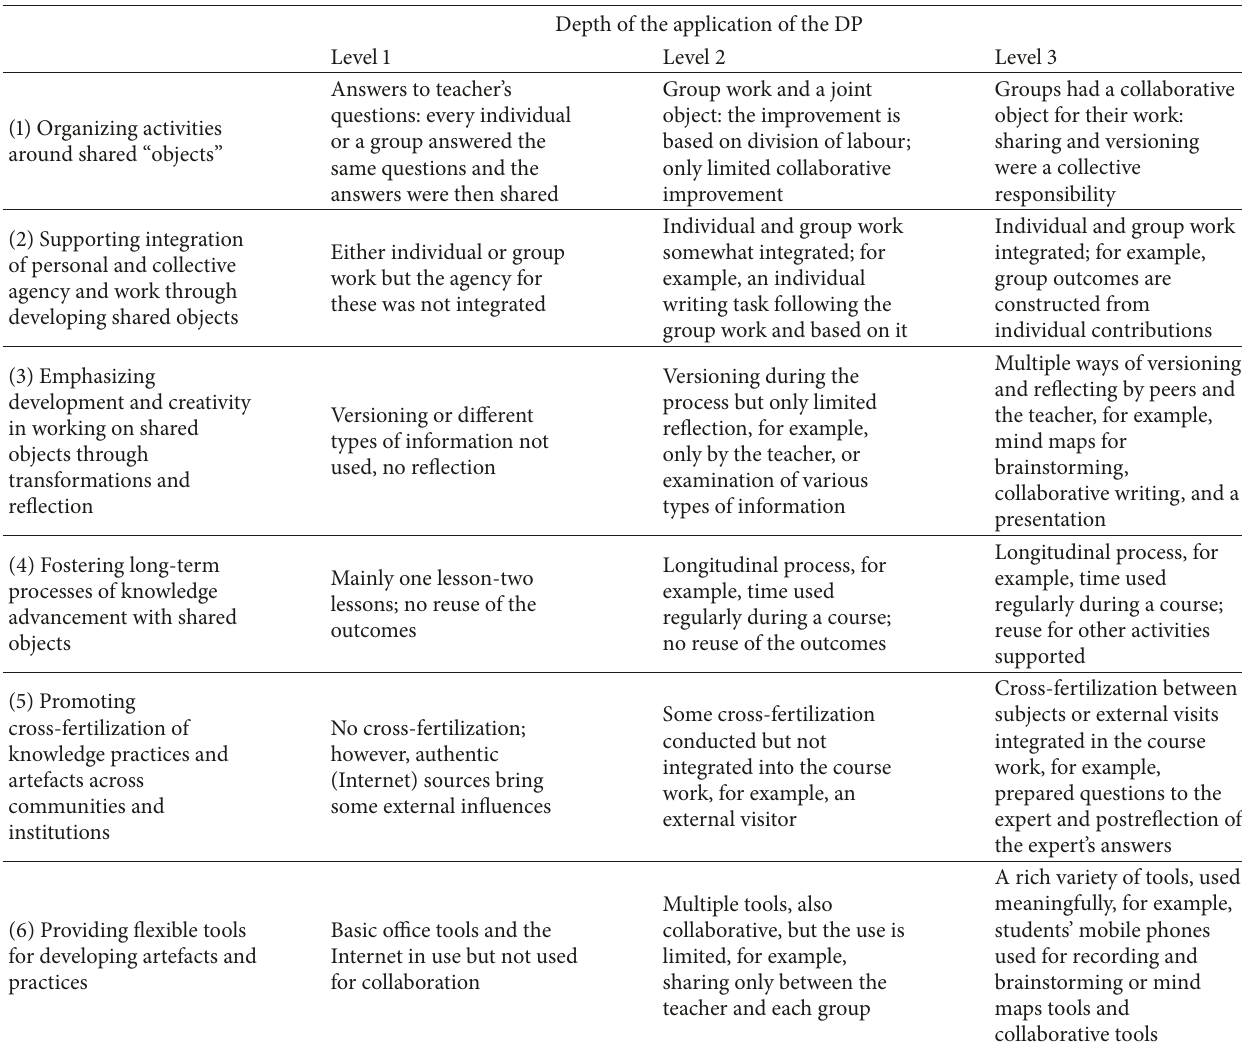
Table 3: The analysis framework of the investigated